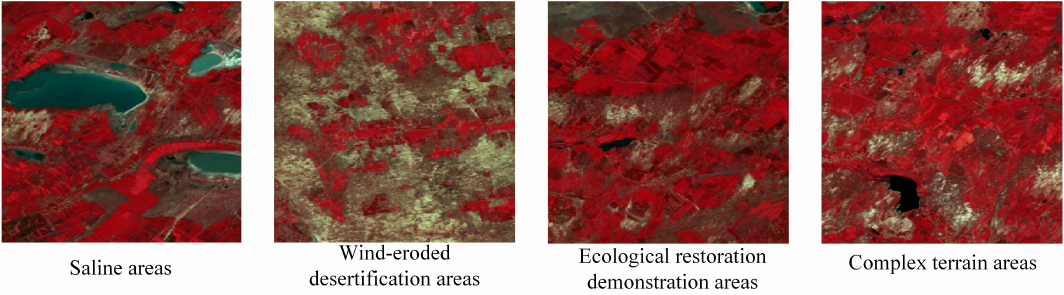
Figure 3. False-color images of the four datasets.